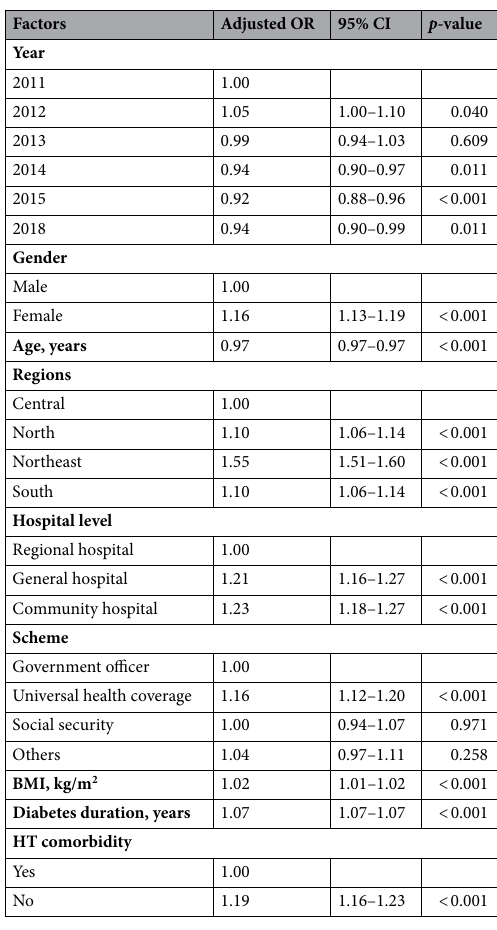
Table 4. Multivariate analysis for factors associated with poor achievement of glycemic control (HbA1c ≥ 7%) among patients with type 2 diabetes in Thailand from 2011 to 2015 and 2018. BMI: body mass index; HT: hypertension; OR: odds ratio; CI: confidence